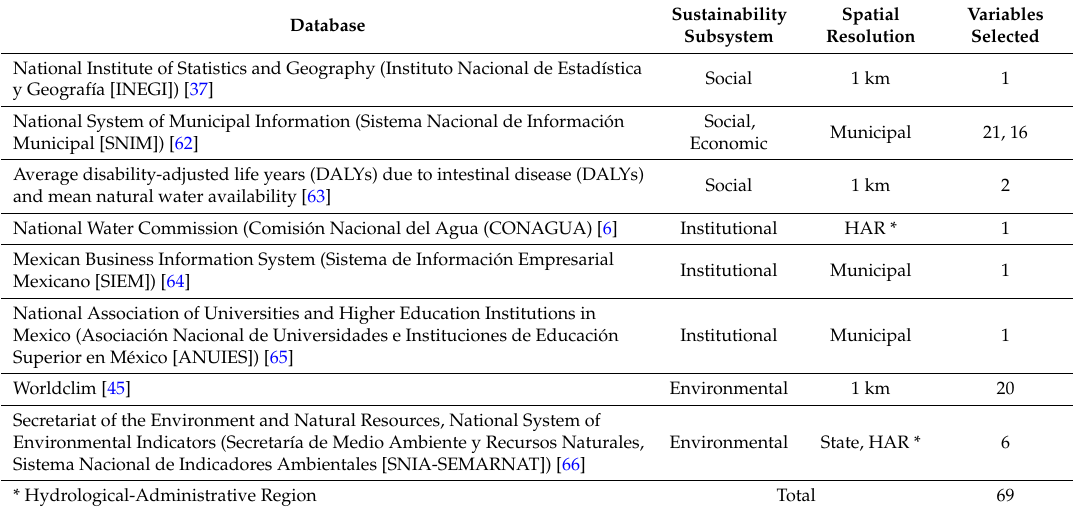
Table A1. Geo-databases used for variable